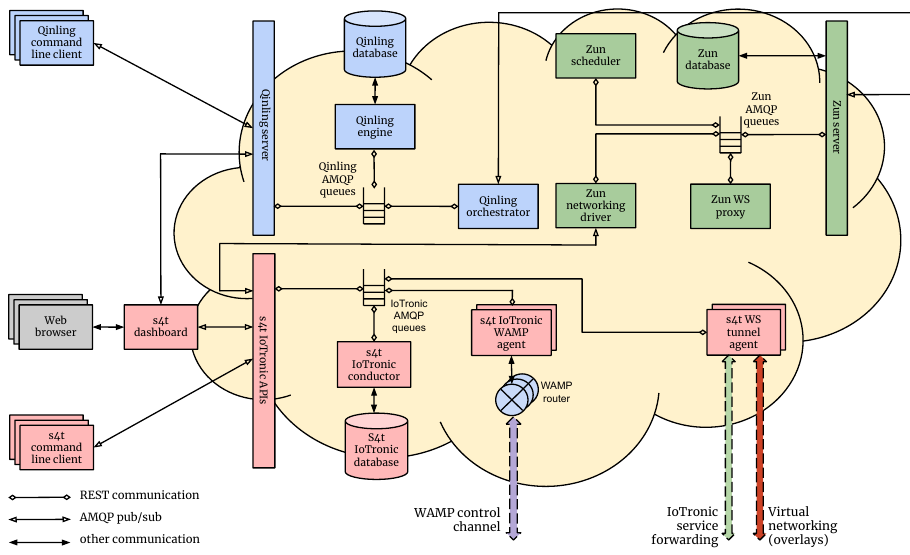
Figure 7. The S4T FaaS system